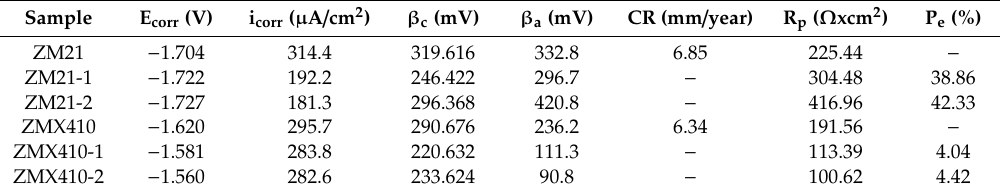
Table 3. Main parameters determined during the corrosion process performed in SBF.